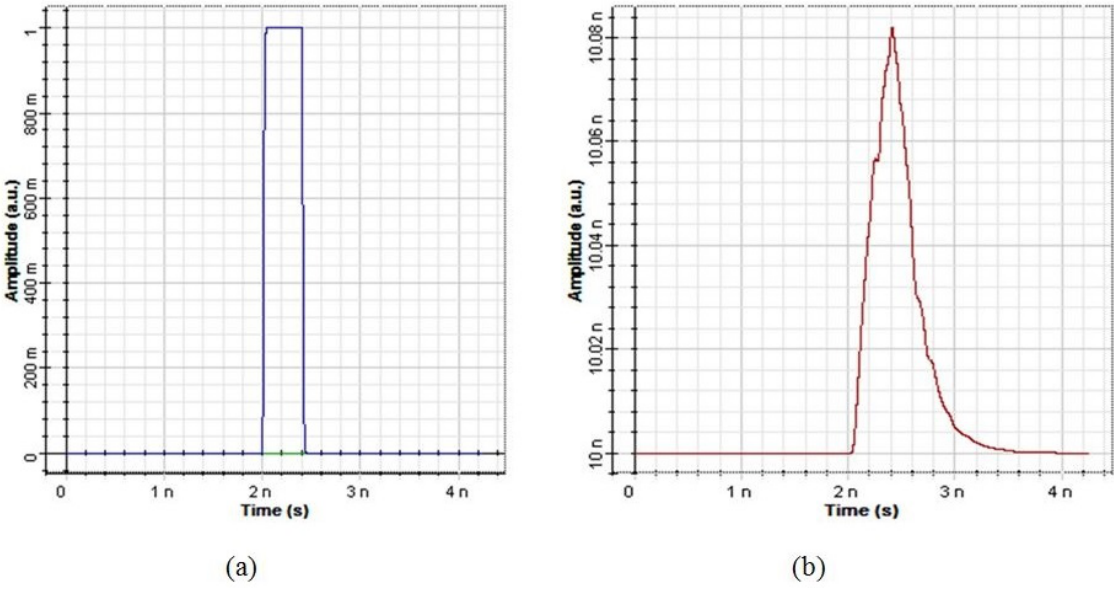
Figure 11. Simulation results from LOS propagation model. ( a ) Input signal. ( b ) Output